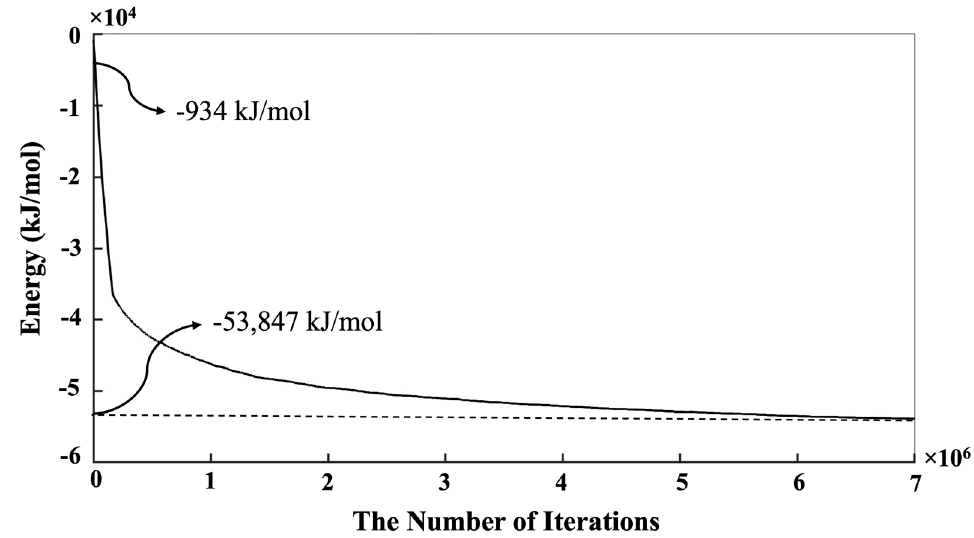
Figure 5. The equilibrium condition was obtained for the energy minimization computation of the silicate particles (taken as starting at 0 iterations) and metakaolinite for 7 million iterations. The point at which the metakaolin is “added” to the system is denoted as iteration 0. Thus, pre-equilibration takes place for an additional “1,000,000” iterations (shown in Figure 4).